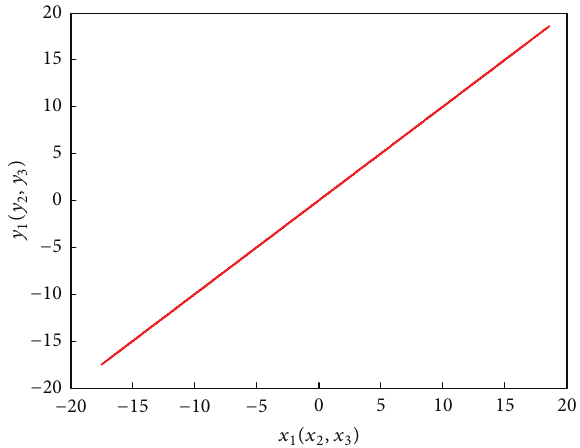
Figure 4: Synchronization behavior of the Lorenz system and the L¨u system.